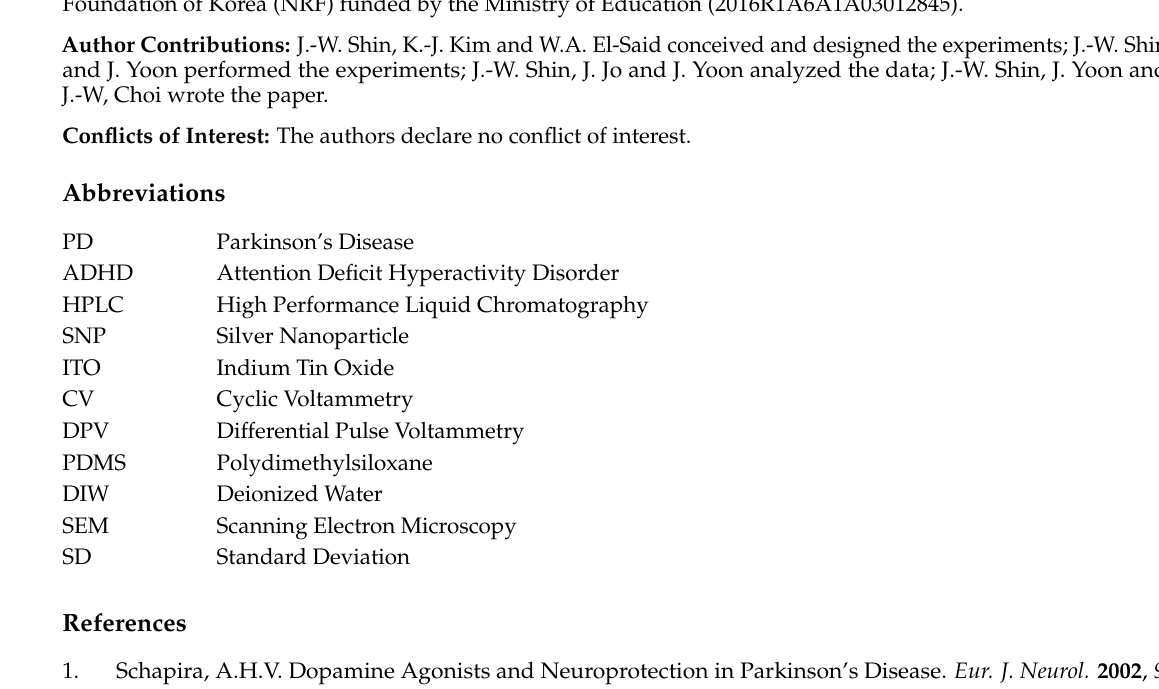
Figure S1: FE-SEM images and EDS of (a) SNP modified electrode and (b) SNP modified electrode covered by graphene oxide, Figure S2: Comparison of CV peaks of dopamine with uric acid and uric acid, Figure S3: (a) Linear sweep voltammetry and (b) comparison of peak current of different electrodes for electroactive area comparison, Figure S4: Amperometric i-t curve of SNP modified electrode covered by graphene oxide with 4% human serum, Figure S5: Electrochemical peak current comparison between SNP modified electrode and SNP modified electrode covered by graphene oxide at 0 h and 24 h, Table S1: Parameters comparison between different